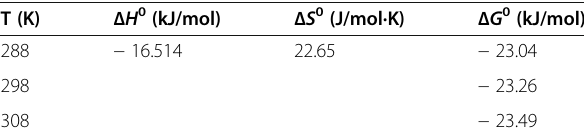
Table 3 The thermodynamic parameters of INS and PHL